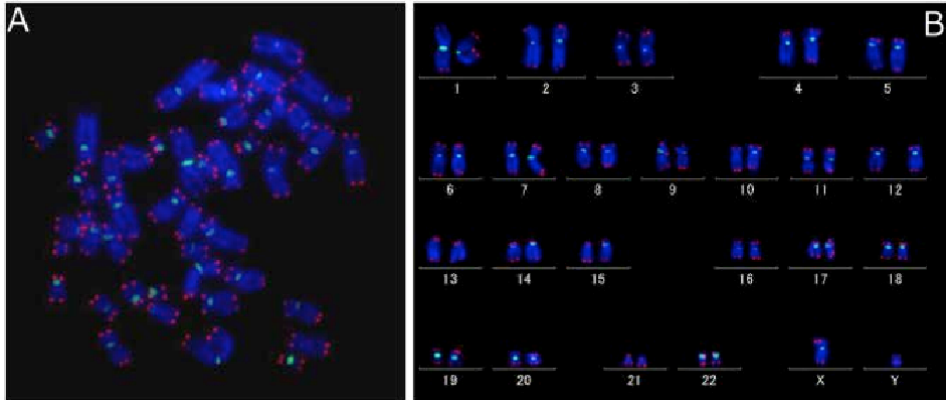
Figure 8. Quantitative FISH on metaphase spread ( A ) with human karyotype ( B ). Figure shows fluorescently dyed telomere (red) and centromere (green) on metaphase spread and then stored into the karyotype [62]. Molecules 2021 , 26 , 3874